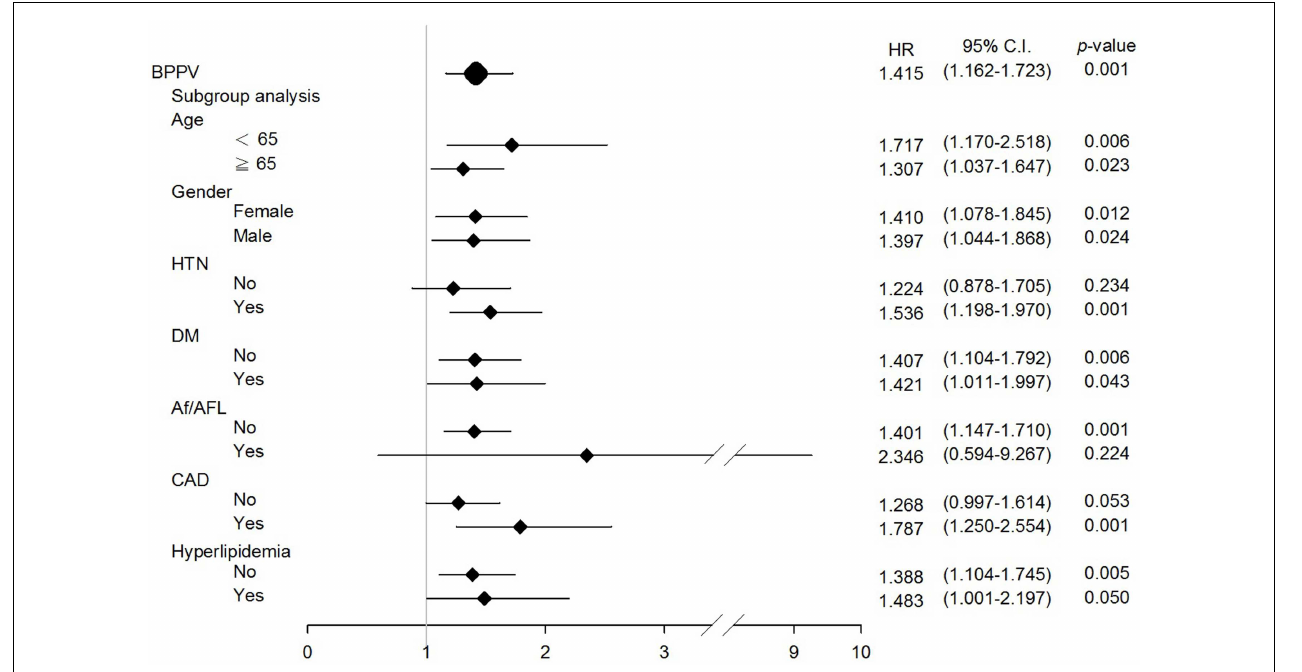
FIGURE 2 | Hazard ratios (HRs) for BPPV of ischemic stroke development in subgroup analysis .